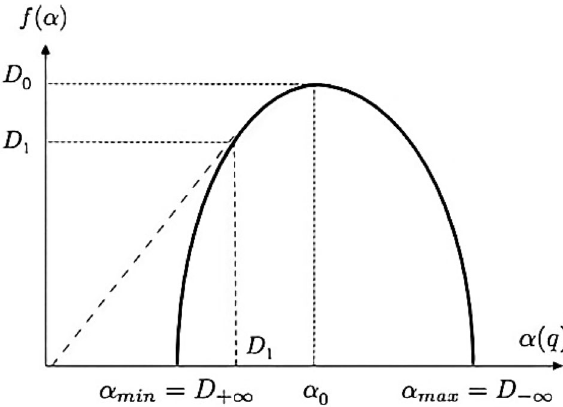
Figure 4. The f ( α ) spectrum curve.